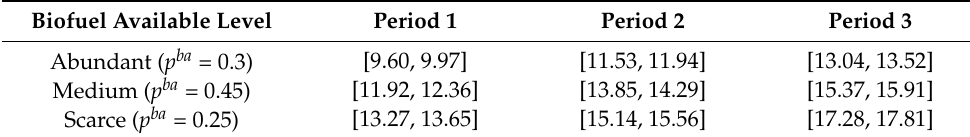
Table 2. Biofuel available amount, 10 3 t [5].